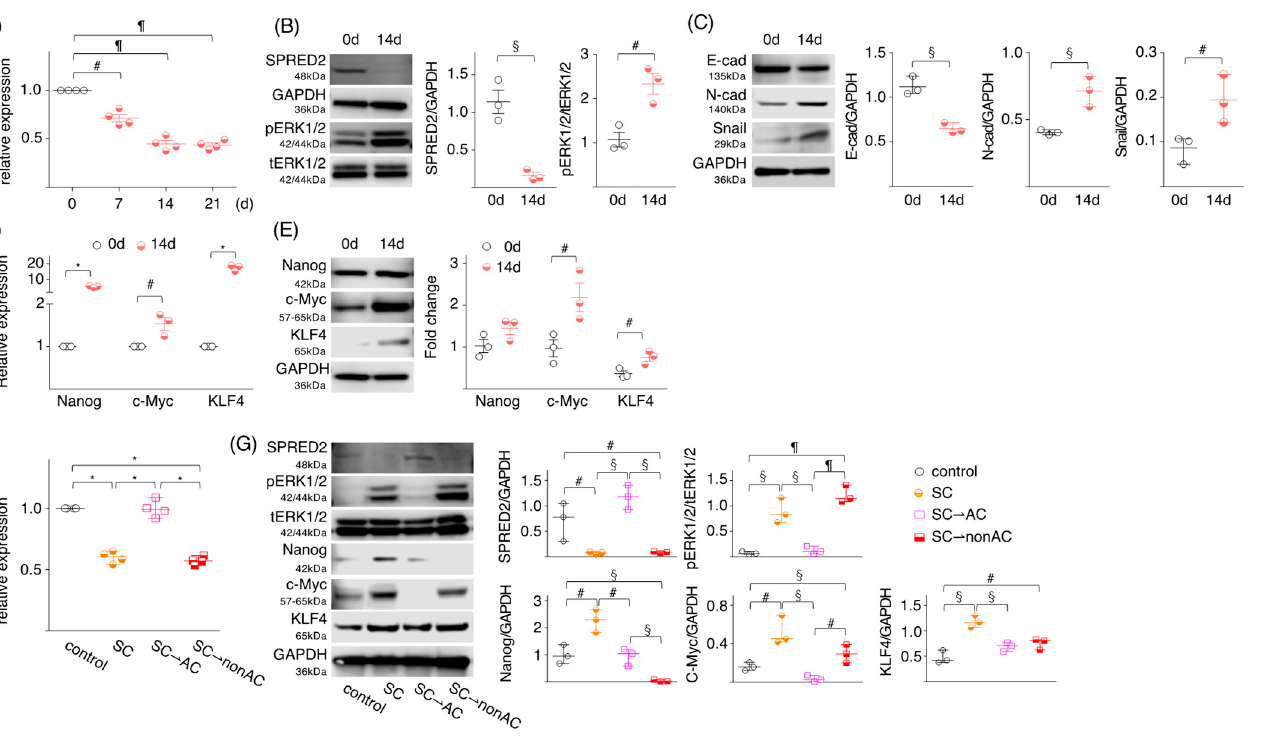
Figure 5. SPRED2 expression level changes under different cell culture conditions. ( A – C ) HepG2 cells (1000 cells) were suspended in FBS-free sphere medium, seeded in ultra-low attachment 96-well plates and incubated at 37 °C for indicated time intervals. ( A ) SPRED2 mRNA expressions in cell extracts were examined by RT-qPCR ( n = 3, each). ( B , C ) The presence of each protein in cell lysates was evaluated by western blotting. Band densities were digitized and semi-quantitated ( n = 3, each). ( D ) mRNA expressions of stemness markers (Nanog, c-Myc and KLF4) were measured by RT-qPCR. ( E ) Protein expressions of stemness markers (Nanog, c-Myc and KLF4) were semi-quantitated by western blotting using indicated primary antibodies ( n = 3, each). ( F , G ) HepG2 cells (1000 cells) were suspended in FBS (+) DMEM or FBS ( − ) sphere medium, and were cultured for 14 days at 37 °C in a standard 96-well plate or in an ultra-low attachment 96-well plate, respectively. A portion of cells used to seed were used as control. Cells cultured in latter conditions were divided into 3 groups. (1) Cells were continued to be cultured in a sphere-forming condition (termed, SC; sphere condition). (2) Cells were suspended in FBS (+) DMEM and cultured for an additional 3 days in a standard 6-well plate (termed, SC ⇀ AC; adherent condition). (3) Cells were suspended in FBS ( − ) sphere medium and cultured for an additional 3 days in a standard 6-well plate (termed, SC ⇀ nonAC). ( F ) SPRED2 mRNA expressions in each cell extract were examined by RT-qPCR ( n = 4, each). ( G ) Cell lysates were prepared, and the presence of each protein was evaluated by western blotting. Band densities were digitized and semi-quantitated ( n = 3, each). # p < 0.05, § p < 0.01, ¶ p < 0.001, * p < 0.0001, two-tailed unpaired t test.